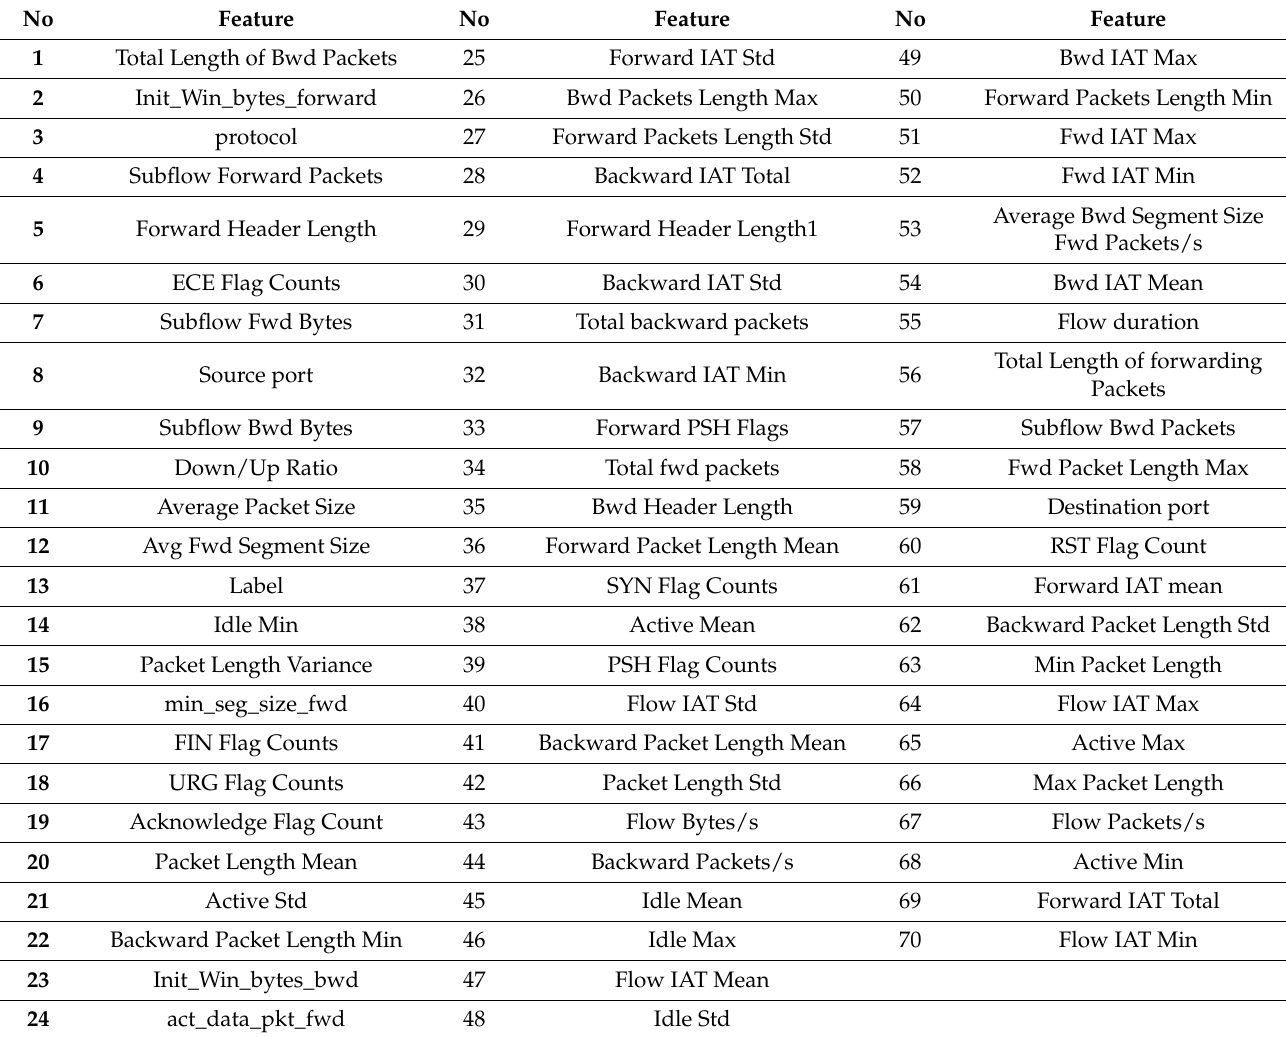
Table 7. Features of the CICIDS2017